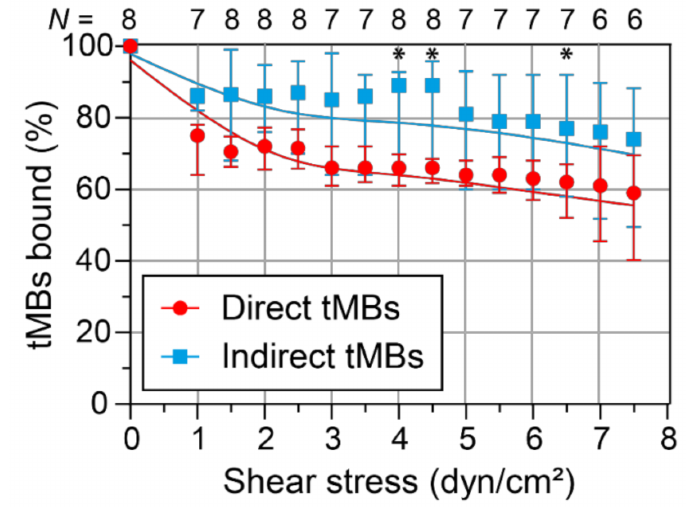
Figure 5. Dissociation of bound targeted microbubbles (tMBs) at increasing shear stress in vitro. The median percentage of bound direct (red) and indirect (blue) microbubbles, relative to the number of microbubbles bound before flow, is plotted with the IQR and curve fitting (restricted cubic spline). Statistical significance is indicated with * p < 0.05. The number of µ -slides analyzed at each shear stress is shown on top of the graph as N number.